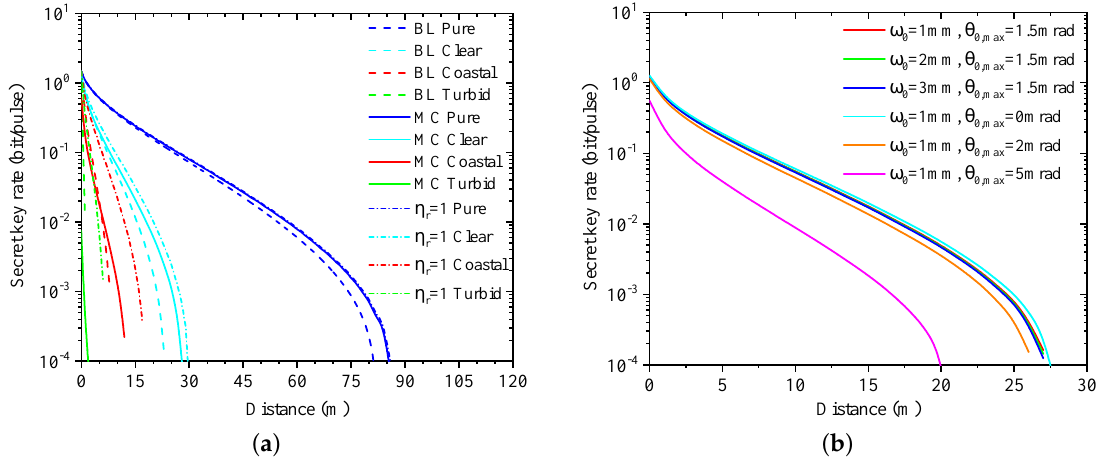
Figure 6. ( a ) Secret key rate of four types of water obtained by Beer’s law and Monte Carlo simulation. The solid lines correspond to the results obtained by Monte Carlo with considering the receiver parameters, the dashed lines correspond to the results obtained by Beer’s law, and the dot-dashed lines correspond to the results obtained by Monte Carlo without considering the receiver parameters. From left to right, the curves correspond, respectively, to the turbid harbor water case, the coastal ocean water case, the clear ocean water case and the pure see water case. ( b ) Secret key rate for different beam width ω 0 and maximum initial divergence angle θ 0, max